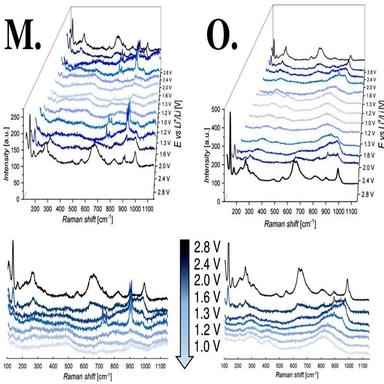
In situ Raman spectra recorded at different potentials, for monoclinic and orthorhombic FeNb11O29 (above, 3D graph) and discharge trend (down, 2D graph).